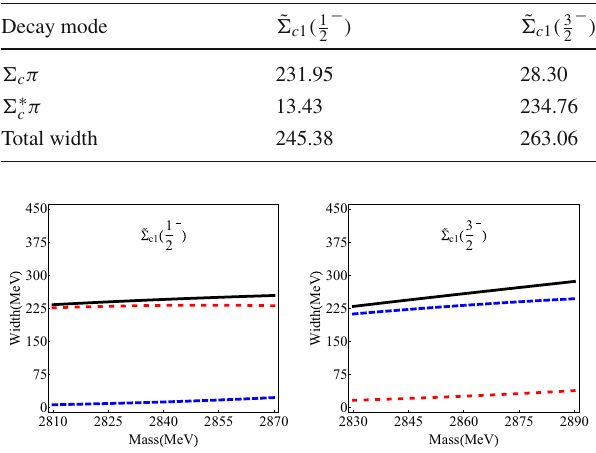
Fig. 6 The total decay widths for the ˜ (cid:4) b ( 1 P ) states versus their initial masses. The black lines correspond to the total decay widths. The red dotted and blue dashed lines stand for the partial decay widths of (cid:4) b π π channels, respectively and (cid:4) ∗ b